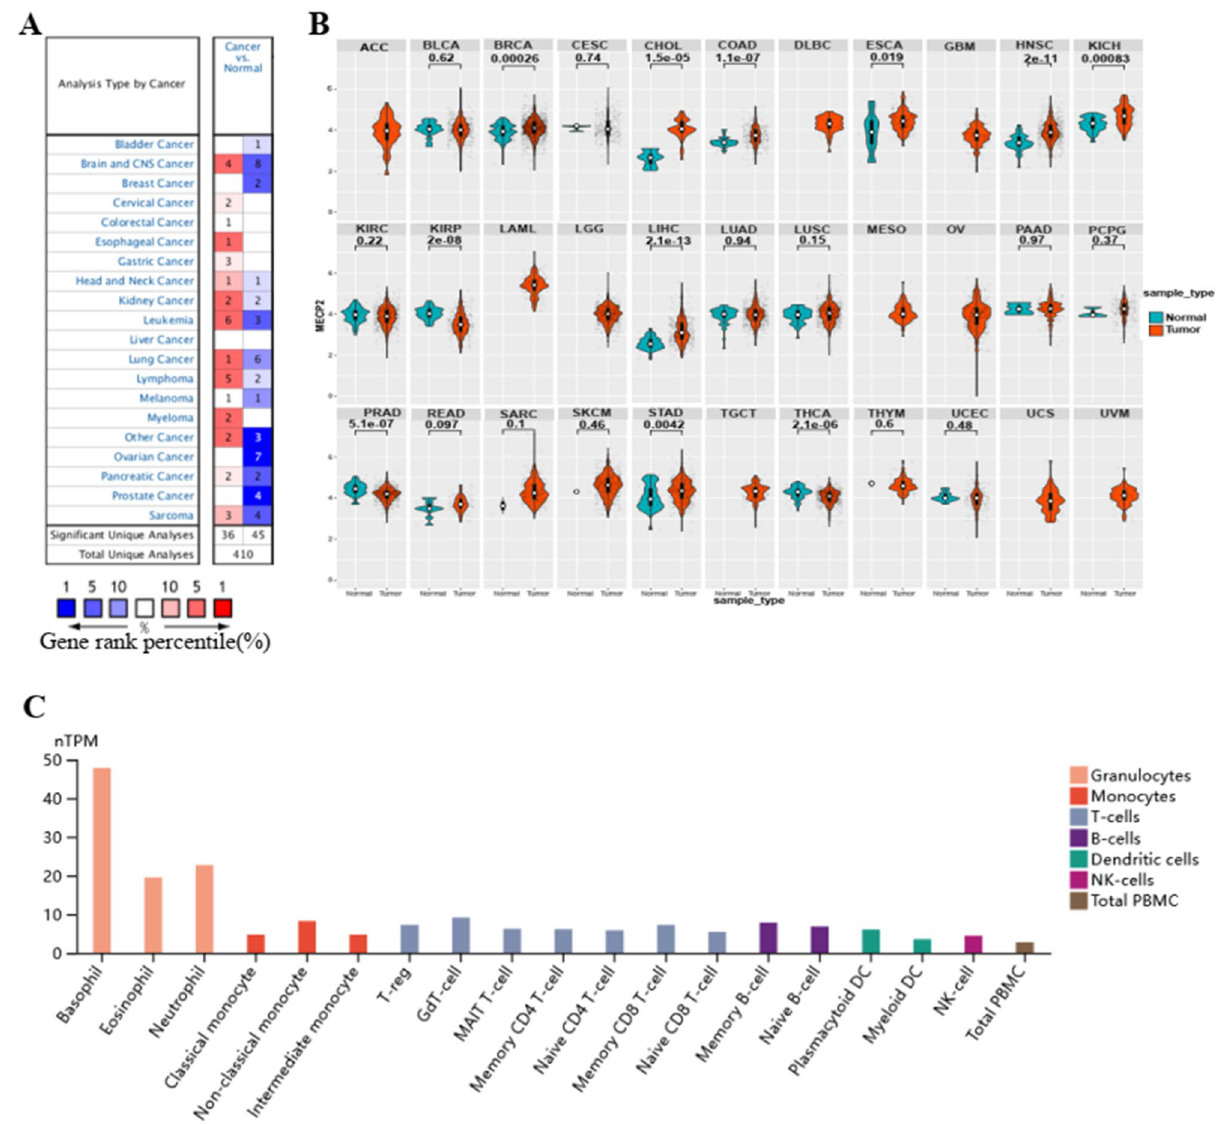
Figure 2. The expression level of the MeCP2 gene in tumors and blood immune cells. (A) The expression level of MeCP2 in various cancer tissues compared with normal tissues in the Oncomine database. (B) The expression level of MeCP2 in various cancer tissues compared with normal tissues from the TCGA database. (C) The expression level of MeCP2 in various blood immune cells was obtained from the HPA BRCA, COAD, KIRP, LUSC, and PCPG, P < 0.05 for all (Fig. S3C). We also used COX methods to analyze the relationship between MeCP2 and survival (OS, DFI, PFI, and DSS) for further validation. According to the forest plots (Fig. 3B), MeCP2 expression acted as a protective prognostic factor (HR < 1, P < 0.05) in CESC (OS), KIRC (OS, DSS, and PFI), and CESC (DSS). MeCP2 expression was considered a risk factor (HR > 1, P < 0.05), namely BRCA (OS), LUSC (PFI and DSS), LGG (OS and DSS), and KIRP (DFI and PFI). Relationship between MeCP2 expression and genetic alteration. We investigated the MeCP2 alteration status of Pan cancers from the cBioPortal database. We found that the highest frequency of MeCP2 alteration was associated with amplification, deep deletion, and mutation. As shown in Fig. 4A, diffuse large B-cell lymphoma had the highest frequency of MeCP2 alterations, including amplification and deep deletion (> 10%), followed by stomach adenocarcinoma (> 6%) and uterine corpus endometrial carcinoma (> 6%). The main type of MeCP2 alteration is missense mutations (89), and R255*/Q was detected in UCEC (n = 2) and LSCC (n = 1) (Fig. 4B). Additionally, MeCP2 mutation was significantly correlated with MSI sensor score (10,054 samples) and mutation count (10,105 samples) in the TCGApan-cancer Atlas Studies ( P < 0.0001) (Fig. 4C,D). The results of Fig. 4E–H showed that altered MeCP2 in UCEC had a better prognosis in disease-specific sur- vival ( P = 0.0306) than patients in the unaltered group but disease-free (0.942) overall survival ( P = 0.0724) and progression-free survival ( P = 0.055) were not different between the two groups. Hence, we investigated the